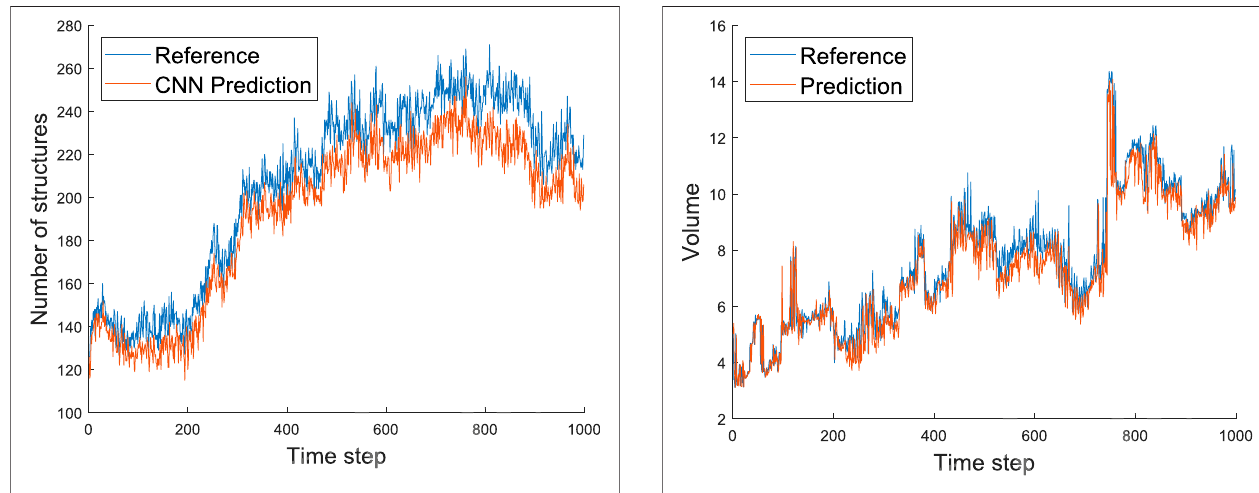
FIGURE 8 | Predicted and reference number of structures as a function ofthetimestepforthewakeregion, i.e.y > 0.2.Weobservethatthenumberof structures is not constant over time.